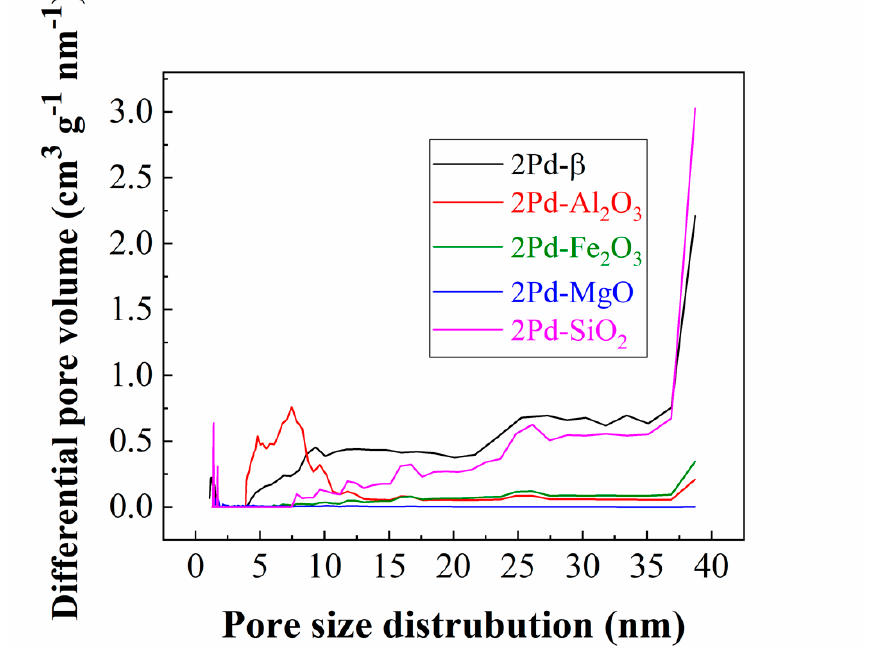
Figure 4. Pore size distribution (estimated from the density functional theory (DFT) method) of Pd supported on β -zeolite, Al 2 O 3 , Fe 2 O 3 , MgO, and SiO 2 catalysts (Pd content: 2 wt.%).